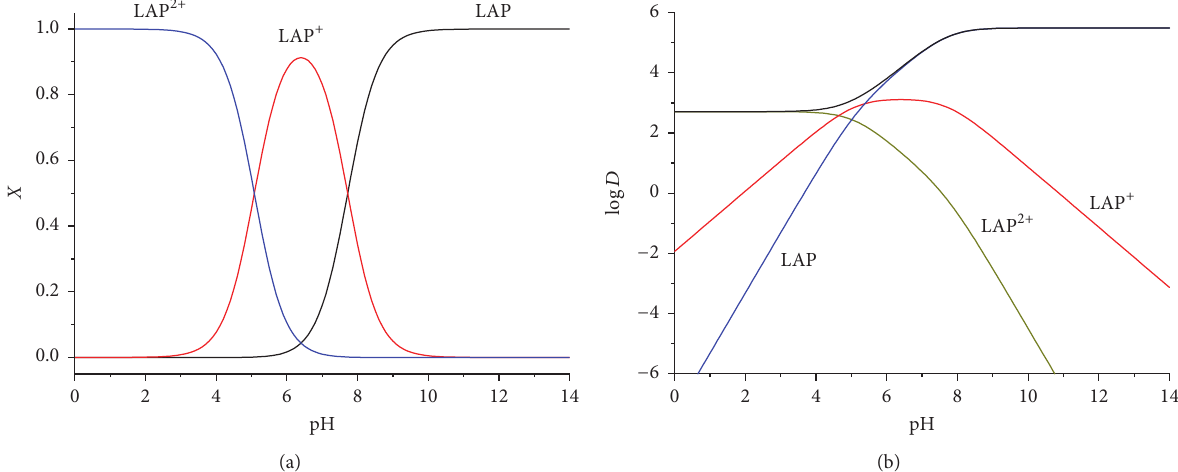
Figure3:(a)LogarithmicdistributiondiagramfortheLAPprotonationmacrospecies.(b)ContributionoftheLAPprotonationmacrospecies to the lipophilicity profile (in black broad